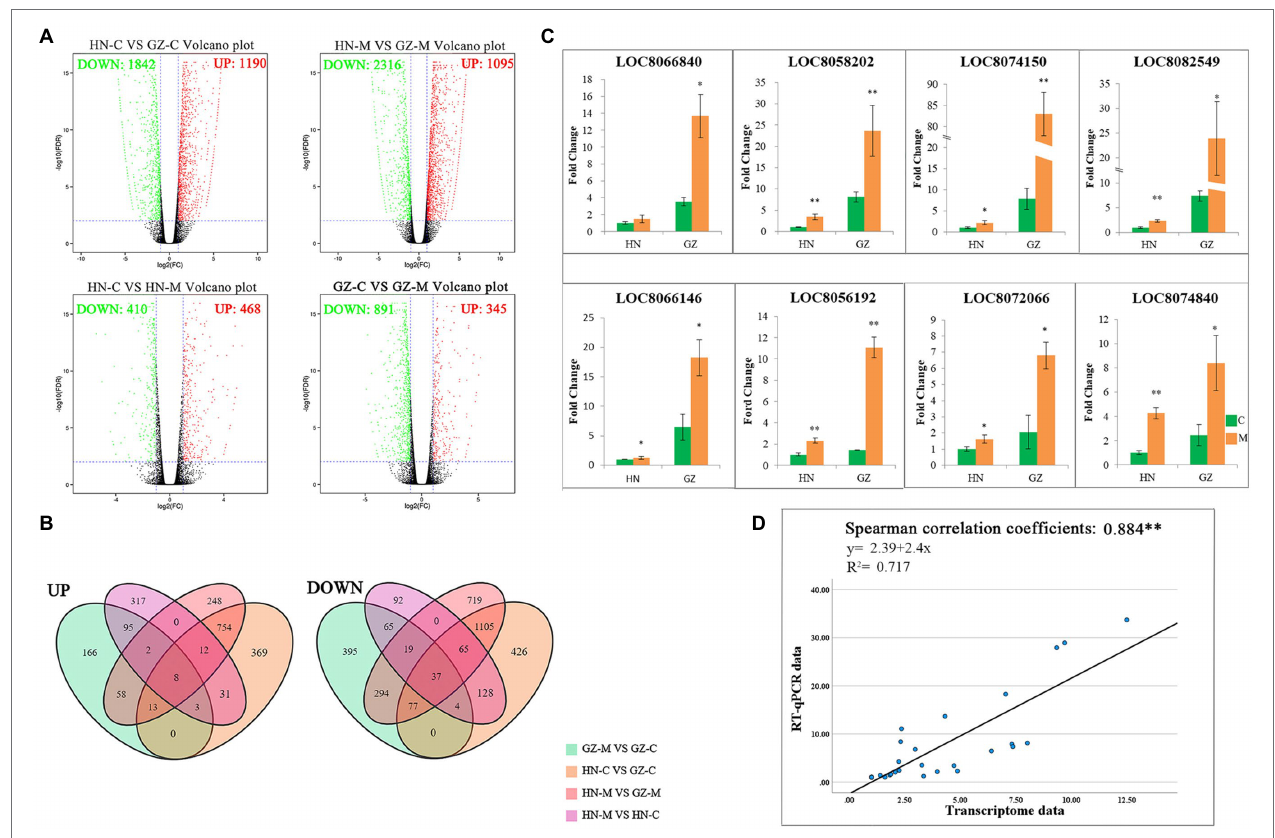
FIGURE 2 | Transcriptome Differences between GZ and HN under salt treatments. (A) Volcano plot analysis on DEGs under control conditions and 48 h (M) salt treatments. The expressions of genes are showed by red spots (up-regulated), green spots (down-regulated). (B) Venn diagram of the DEGs under different salt treatments. UP: up-regulated, DOWN, down-regulated. (C) RT-qPCR of up-regulated expression genes. Error bars represent standard errors of three biological replicates. The statistical significance was determined by the Student’s t test (** p < 0.01; * p < 0.05). (D) Linear regression between the levels of RT-qPCR data and transcript